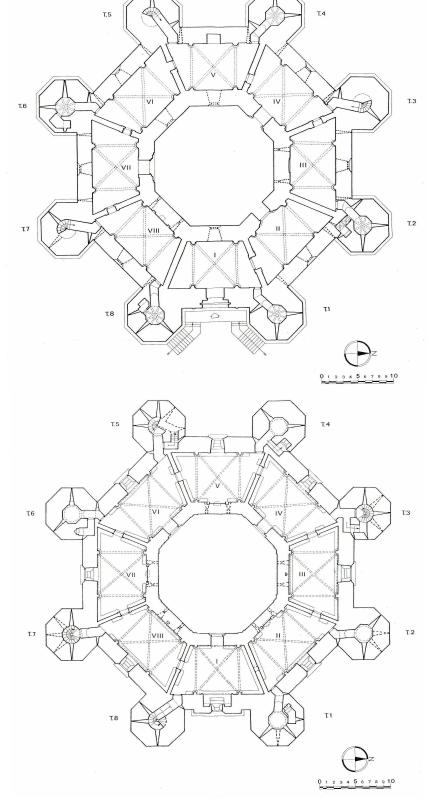
Figure 3. Ground floor plan (above) and first floor